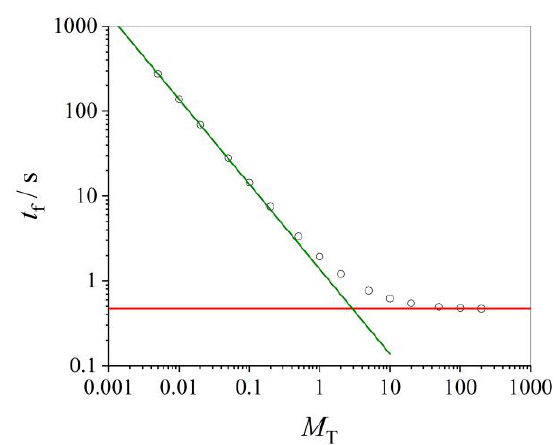
Figure 4. The final time t f is plotted versus the triple junction mobility M T . The dots mark the di ff erent simulations for values of M T ranging from 0.005 to 200. The red line shows the curvature driven regime where the final time remains constant even if M T is increased. The green line shows the limit of triple point controlled growth.